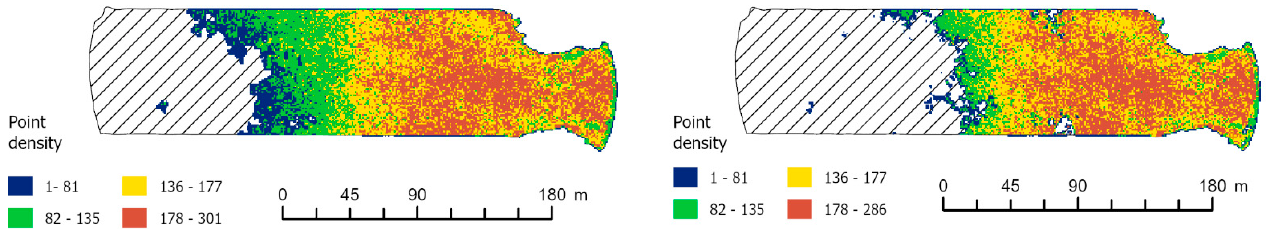
Figure 7. Density of point cloud per 1 m 2 for the PCA cloud ( left ) and the PCG cloud ( right ).